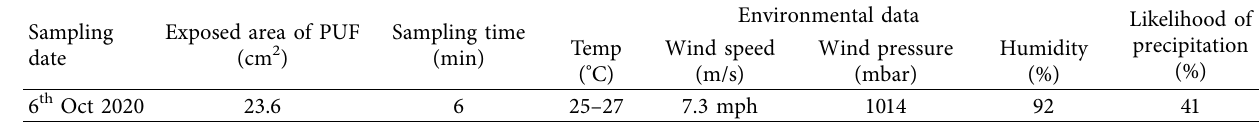
Table 1: Sampling conditions.